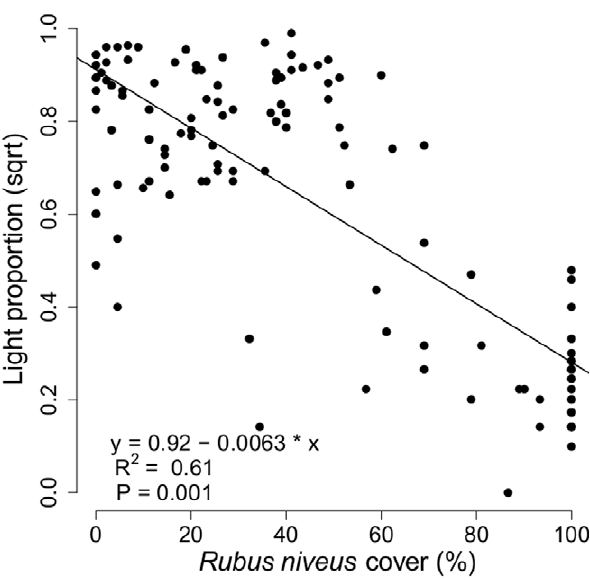
Figure 5. Vertical structure description of the forest using percent of intercepts by height class within each of the R. niveus cover categories. Height classes can sum to values that exceed 100% because of the multiple strata in the forest.